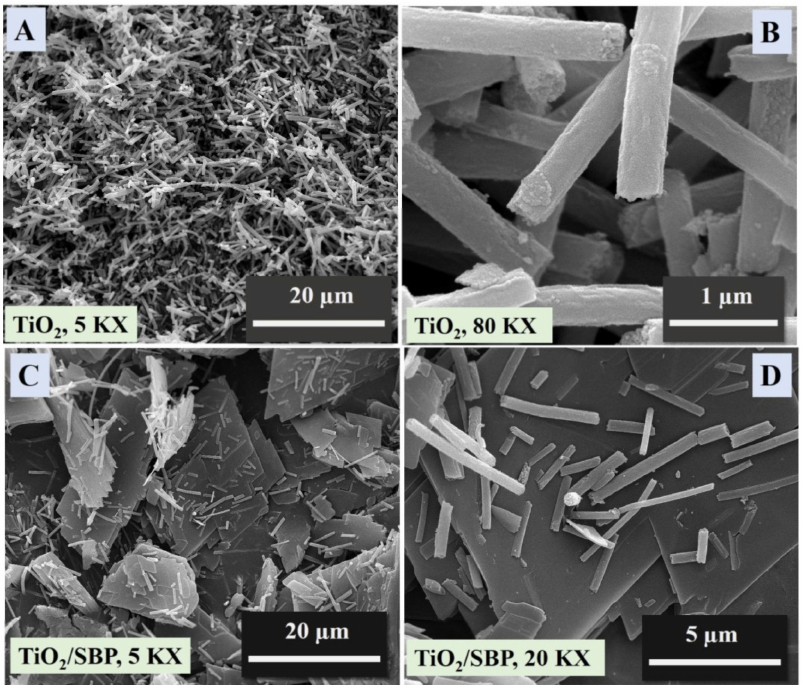
Figure 16. SEM images of [TiO 2 NFs] ( A , B ) and [TiO 2 NFs/SBP] ( C , D ). (Reprinted with permission from Ref. [243]. Copyright 2013 Egyptian Journal of Petroleum